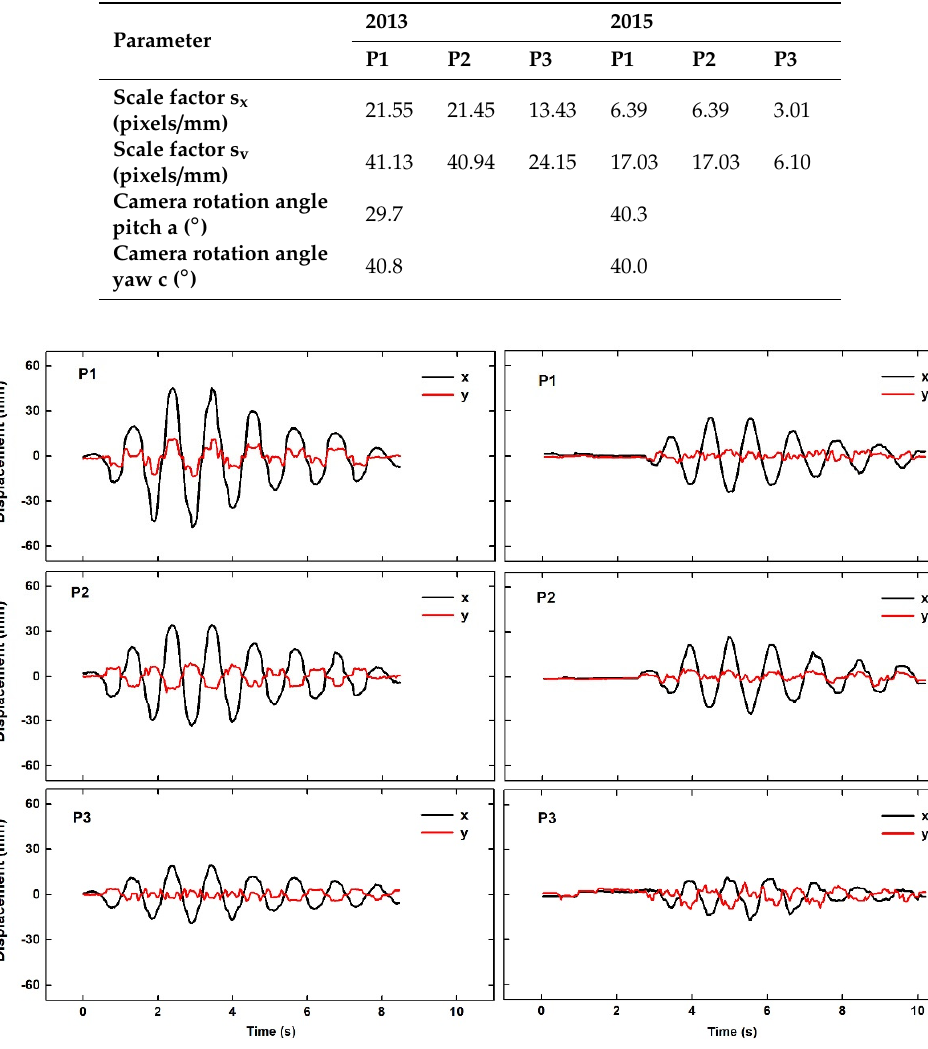
Figure 5. A comparative plot of the spectra of the free attenuation intervals of the oscillation of point P2 for the two years. The spectra are normalized to their maximum amplitude and reflect the first lateral modal frequency of the bridge (only the free attenuation intervals were analyzed).